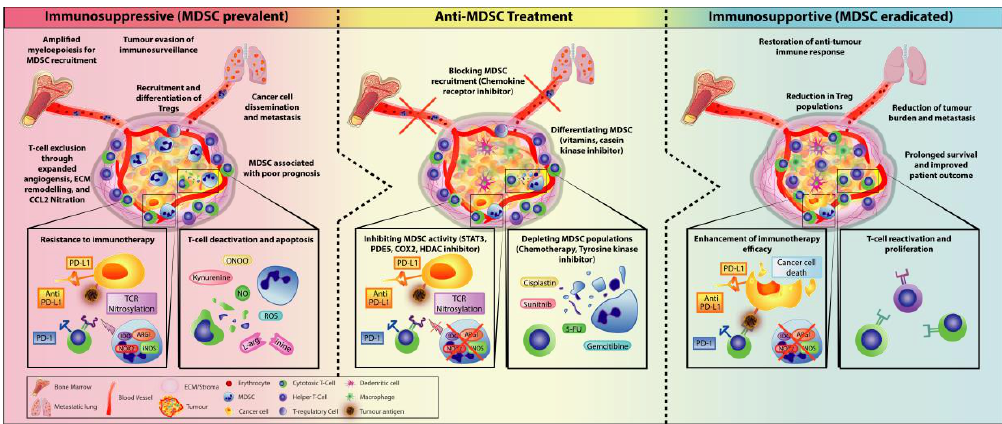
Figure 7. Treatment of MDSC to alleviate an immunosuppressive environment as an approach to enhancing immunotherapeutic treatments by shifting towards an immunosupportive